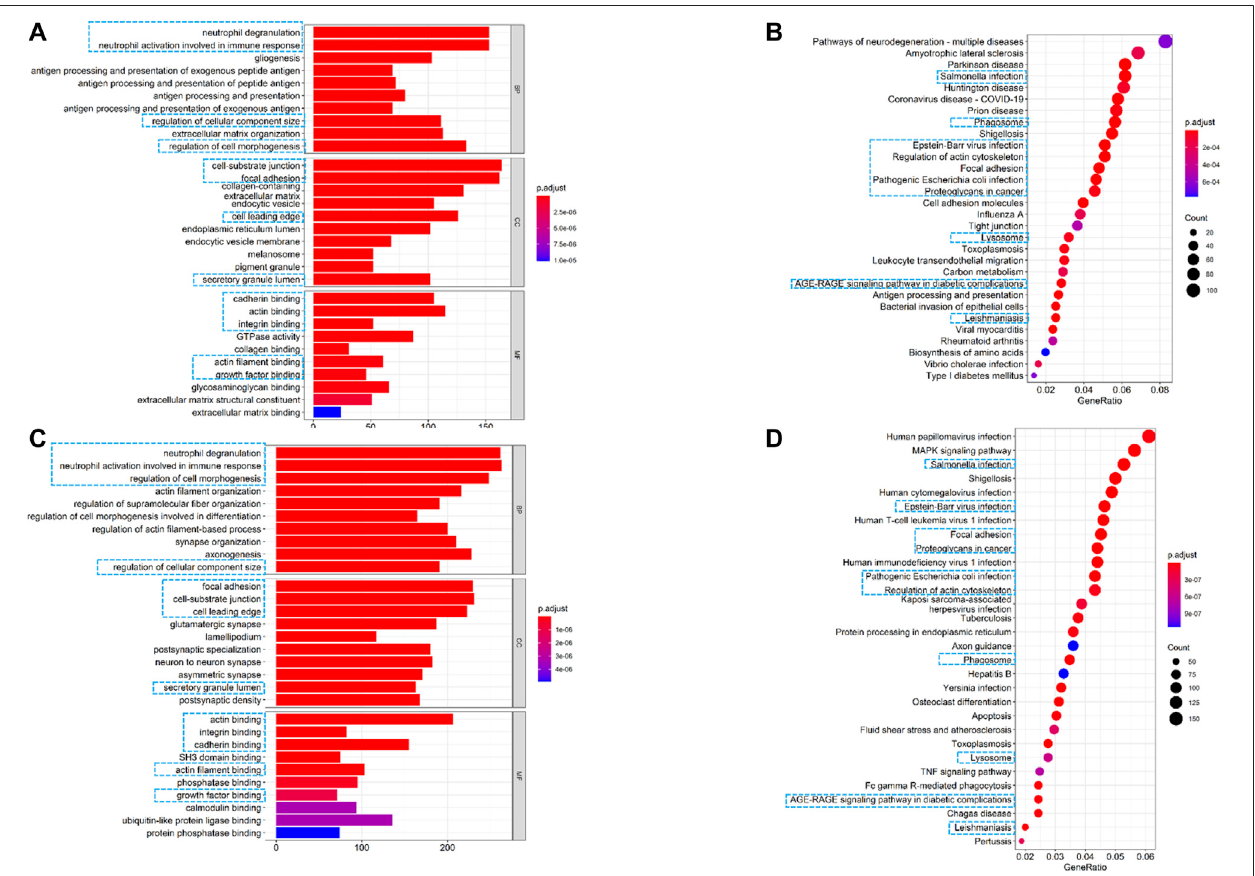
FIGURE 7 | Altered functional characteristics related to the seven-FRG signature. (A) Representative results of GO in TCGA cohort. (B) KEGG analyses in TCGA cohort. (C) Representative results of GO in the CGGA cohort. (D) KEGG analyses in the CGGA cohort. The blue rectangles indicate the overlapped terms between the two